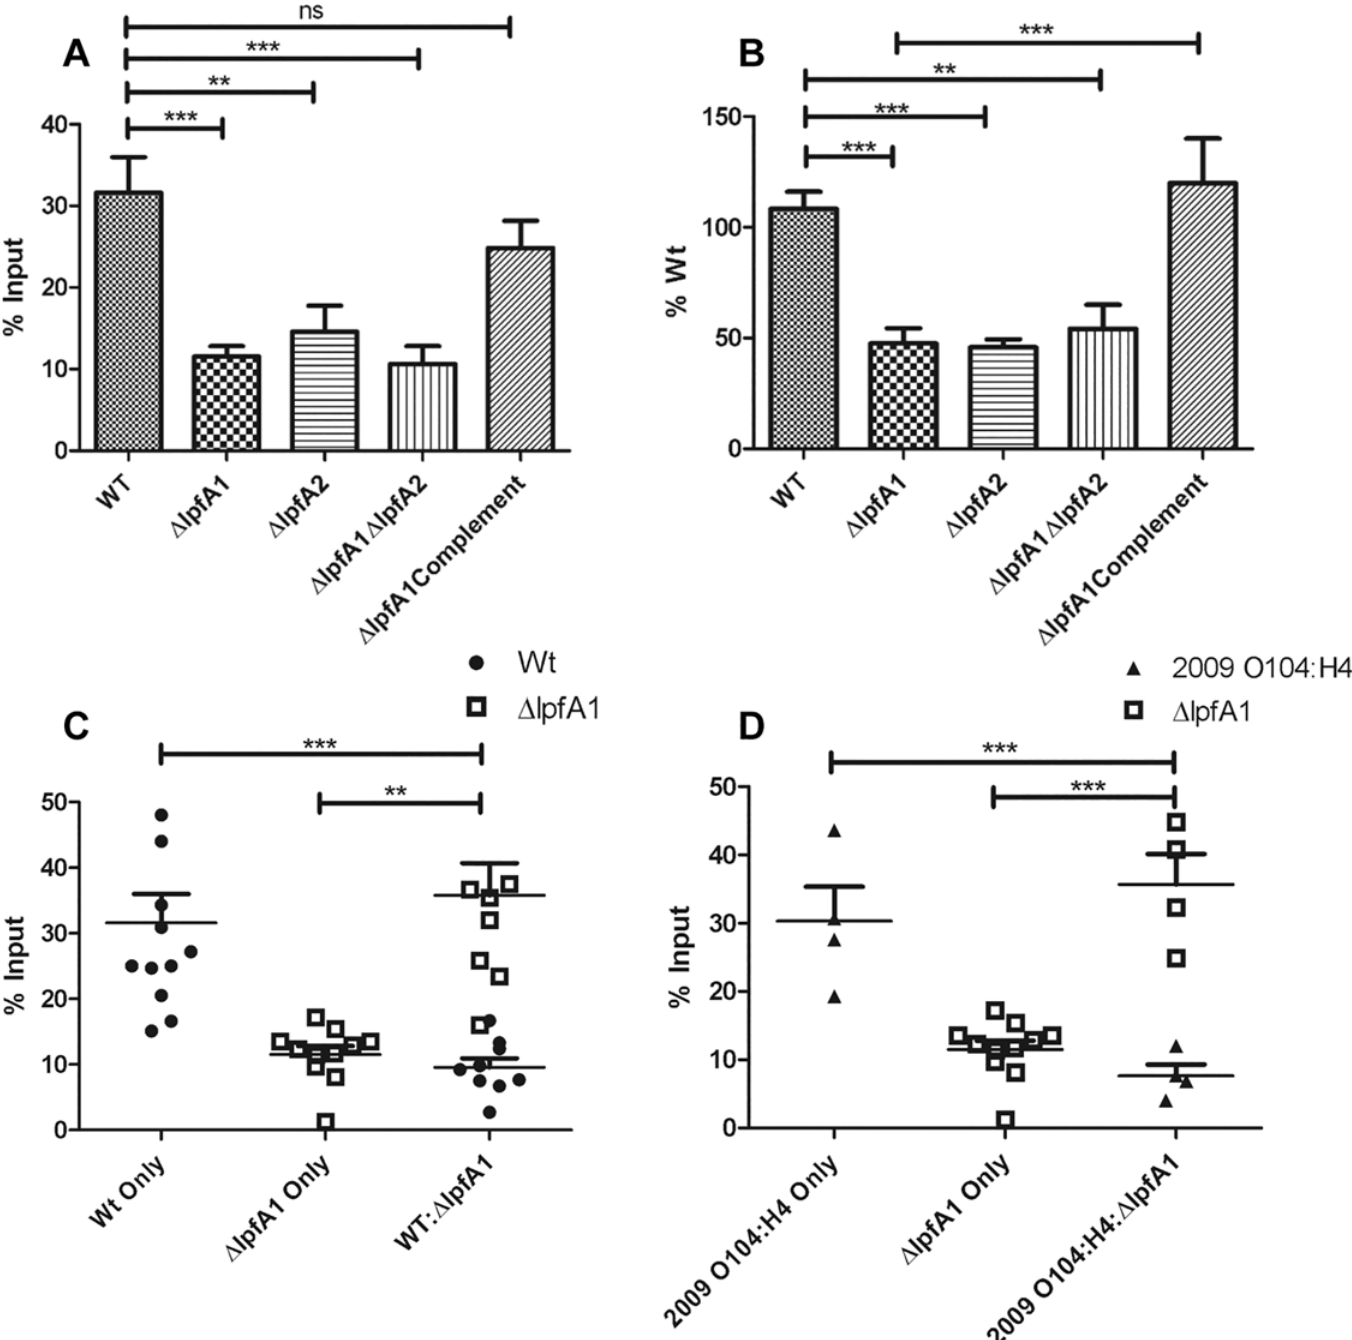
Fig 3. The Effect of lpfA1 and lpfA2 mutation on adhesion to polarized epitheial cell. CFUs recovered after a 3 h incubation of wild type O104:H4 2011 c3494, Δ lpfA1 , Δ lpfA2 , Δ lpfA1 Δ lpfA2 , and Δ lpfA1 complemented strains were calculated as percent input (A) and input compared to wild type (B). Competition assays of (C) O104:H4 2011 c3494 wild type and Δ lpfA1 and (D) O104:H4 2009 2050 wild type and O104:H4 c3494 Δ lpfA1 are expressed as percent input of CFUs recovered. All experiments were done with an MOI of 100 and bacteria was recovered and quantified at 3 h post-infection. Error bars indicated SEM of 2 – 3 independent experiments each performed with duplicate or triplicate